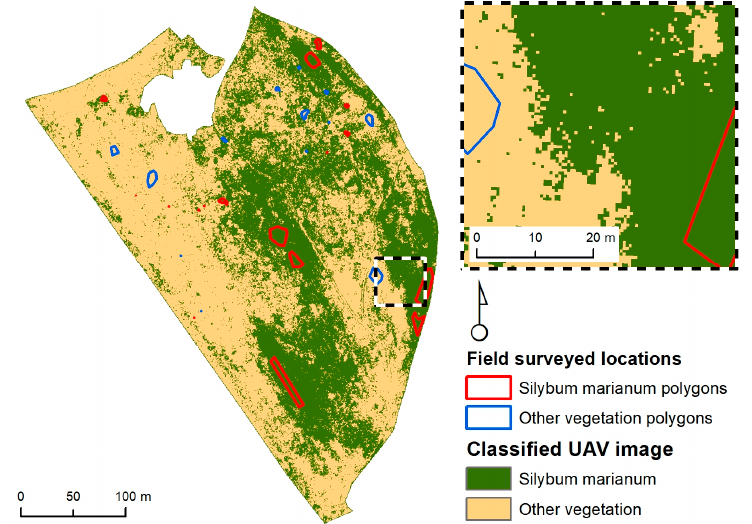
Figure 5 . S. marianum weed mapping based on MLP-ARD prediction. Green is S. marianum and yellow is other vegetation.